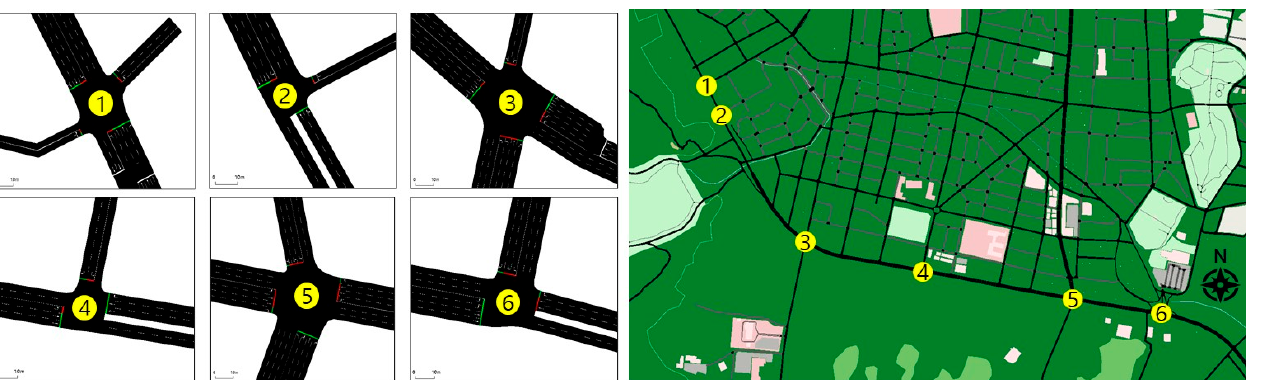
Figure 4. Phase duration ratio of scenario 1: ( a ) Left intersection; ( b ) Right intersection.